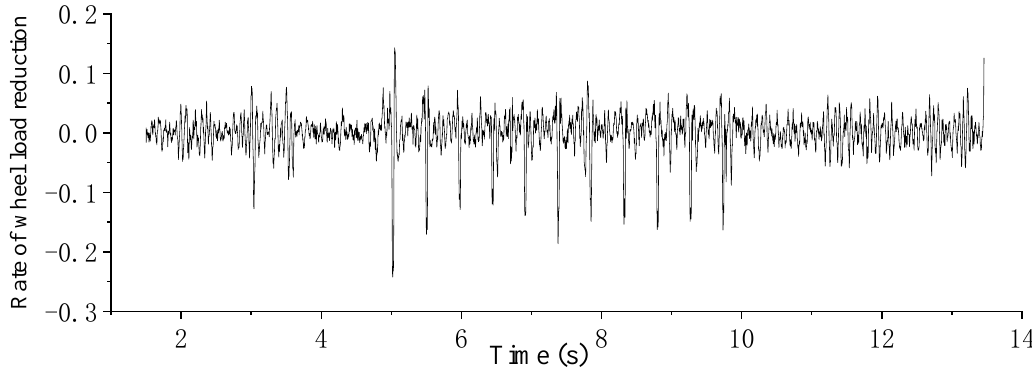
Figure 17. Time history curve of rate of wheel load reduction. The findings from Figures 18–25 show that the vertical acceleration of the car body, Sperling index, WR vertical force, rate of wheel load reduction and the vertical acceleration of the bridge midspan and beam joint positively correlates with the longitudinal level at the beam joint and train